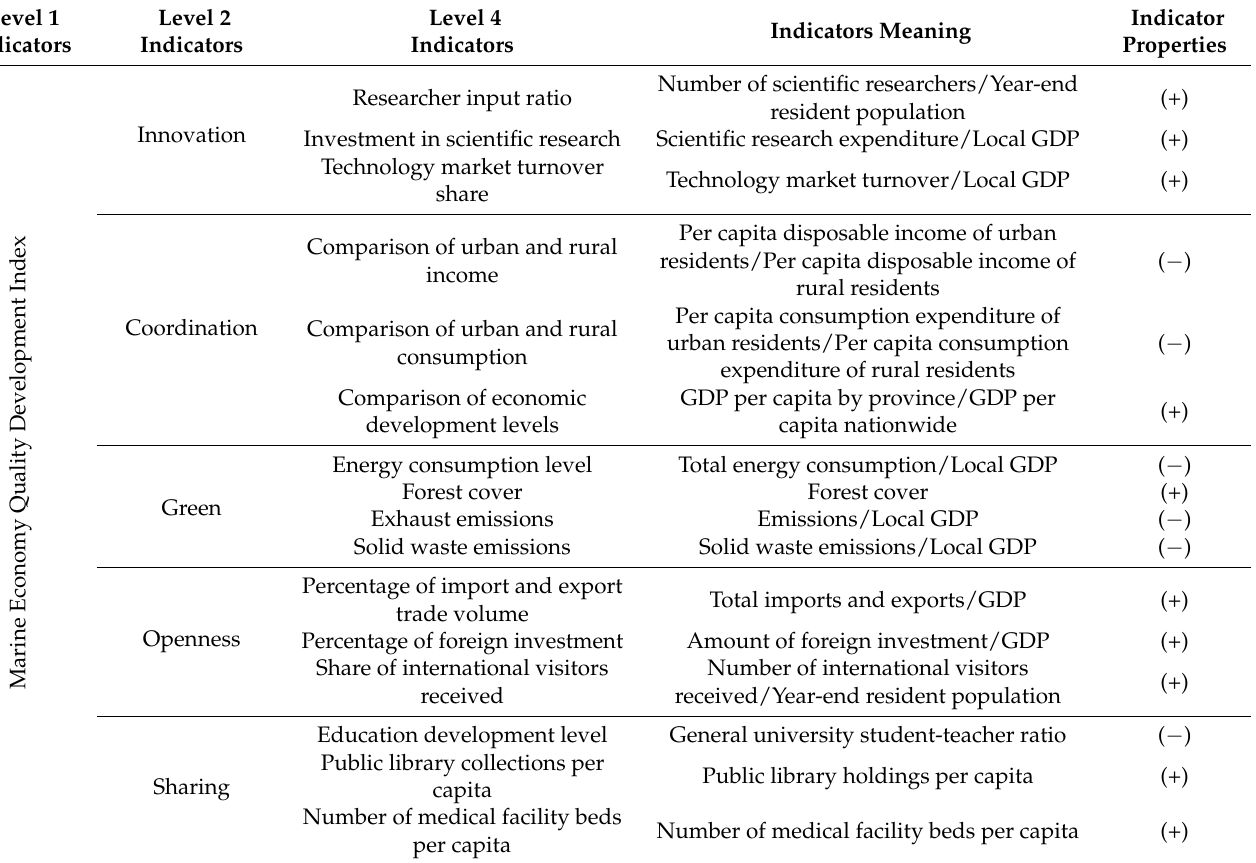
Table 1. Economic quality development index